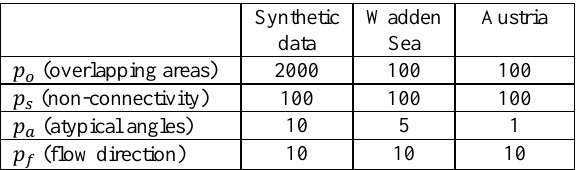
Table 1. Parameter settings of the penalising factors in the prior energy terms (equations